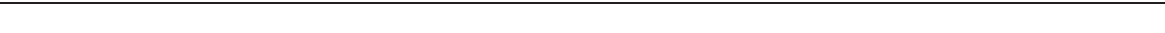
Fig. 1 ZCCHC3 positively regulates dsDNA-triggered signaling. a ZCCHC3 activates the IFN- β promoter in a dose-dependent manner. HEK293 cells were transfected with the IFN- β reporter and increased amounts of ZCCHC3 plasmid for 18 h, and then left un-infected or infected with HSV-1 for 12 h before luciferase assays. b Effects of ZCCHC3 on transcription of downstream genes induced by HSV-1. Control HFF cells and HFFs stably expressing ZCCHC3 were infected with HSV-1 for the indicated times before qPCR analysis. c Effects of ZCCHC3 on transcription of downstream genes induced by cytosolic dsDNA. Control and HFFs stably expressing ZCCHC3 were transfected with HSV120 (3 μ g/ml) for 4 h before qPCR analysis. d Effects of ZCCHC3- de fi ciency on transcription of downstream genes induced by HSV-1. ZCCHC3- KO HFFs were generated by the CRISPR-Cas9 method. ZCCHC3-KO and control HFFs were left un-infected or infected with HSV-1 for the indicated times before qPCR analysis. ZCCHC3-de fi ciency in the KO cells was con fi rmed by immunoblotting analysis (right blots). e Effects of ZCCHC3 on transcription of downstream genes induced by cytosolic dsDNA. ZCCHC3-KO and control HFFs were transfected with the indicated nucleic acids (3 μ g/ml) for 4 h before qPCR analysis. f Effects of ZCCHC3-de fi ciency on HSV-1-induced phosphorylation of TBK1 and IRF3. ZCCHC3-KO and control HFFs were left un-infected or infected with HSV-1 for the indicated times before immunoblotting analysis. g Effects of ZCCHC3-de fi ciency on IFN- β -induced transcription of downstream genes. Control and ZCCHC3- KO THP1 cells were generated by the CRISPR-Cas9 method. The cells were left un-treated or treated with IFN- β (100 ng/ml) for 6 h before qPCR analysis. h Effects of ZCCHC3-de fi ciency on IFN- β -induced phosphorylation of STAT1. ZCCHC3-KO and control THP1 cells were left un-treated or treated with IFN- β (100 ng/ ml) for the indicated times before immunoblotting analysis. * P < 0.05, ** P < 0.01 (unpaired t test). Data are representative of at least two